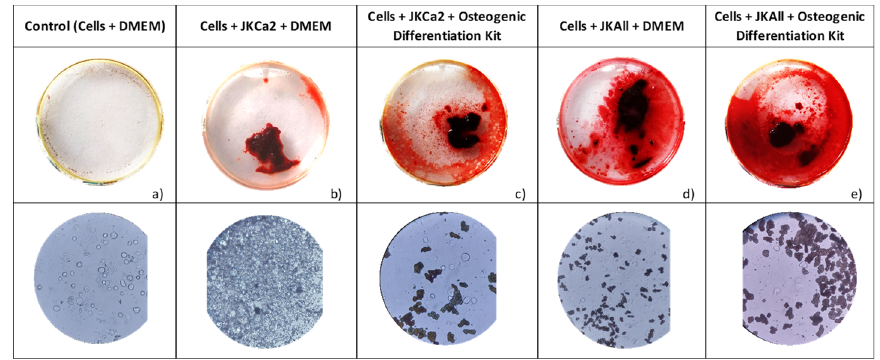
Figure 10. Representative images of the mineral deposition in swine dental pulp stem cells on day 21 by ARS, with their respective micrographs: ( a ) control (cells and DMEM); ( b ) cells, JKCa2 and DMEM; ( c ) cells, JKCa2 and osteogenic differentiation kit; ( d ) cells, JKAll and DMEM; ( e ) cells, JKAll and osteogenic differentiation kit.